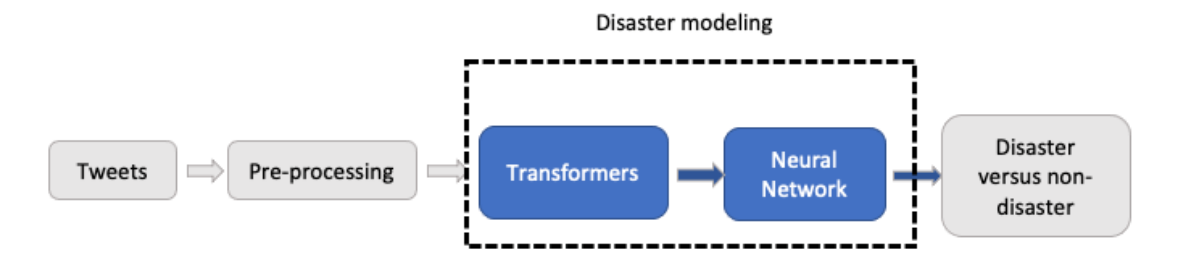
Figure 1. Disaster detection pipeline.